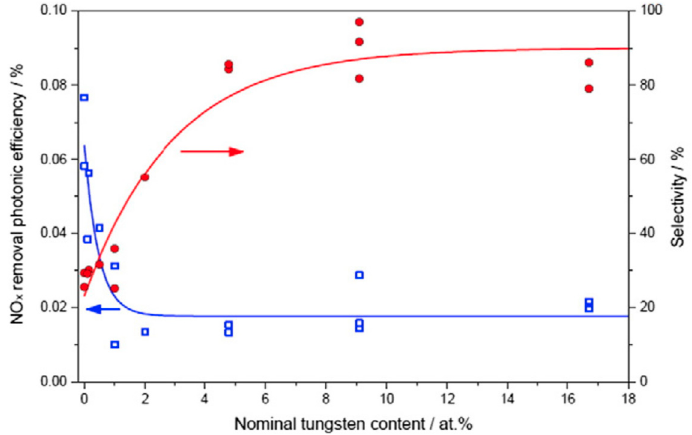
Figure 41. Plots illustrating the photonic efficiency of NO x removal and nitrate selectivity of W-modified TiO 2 illuminated under broadband radiation. Adapted with permission from Bloh et al.